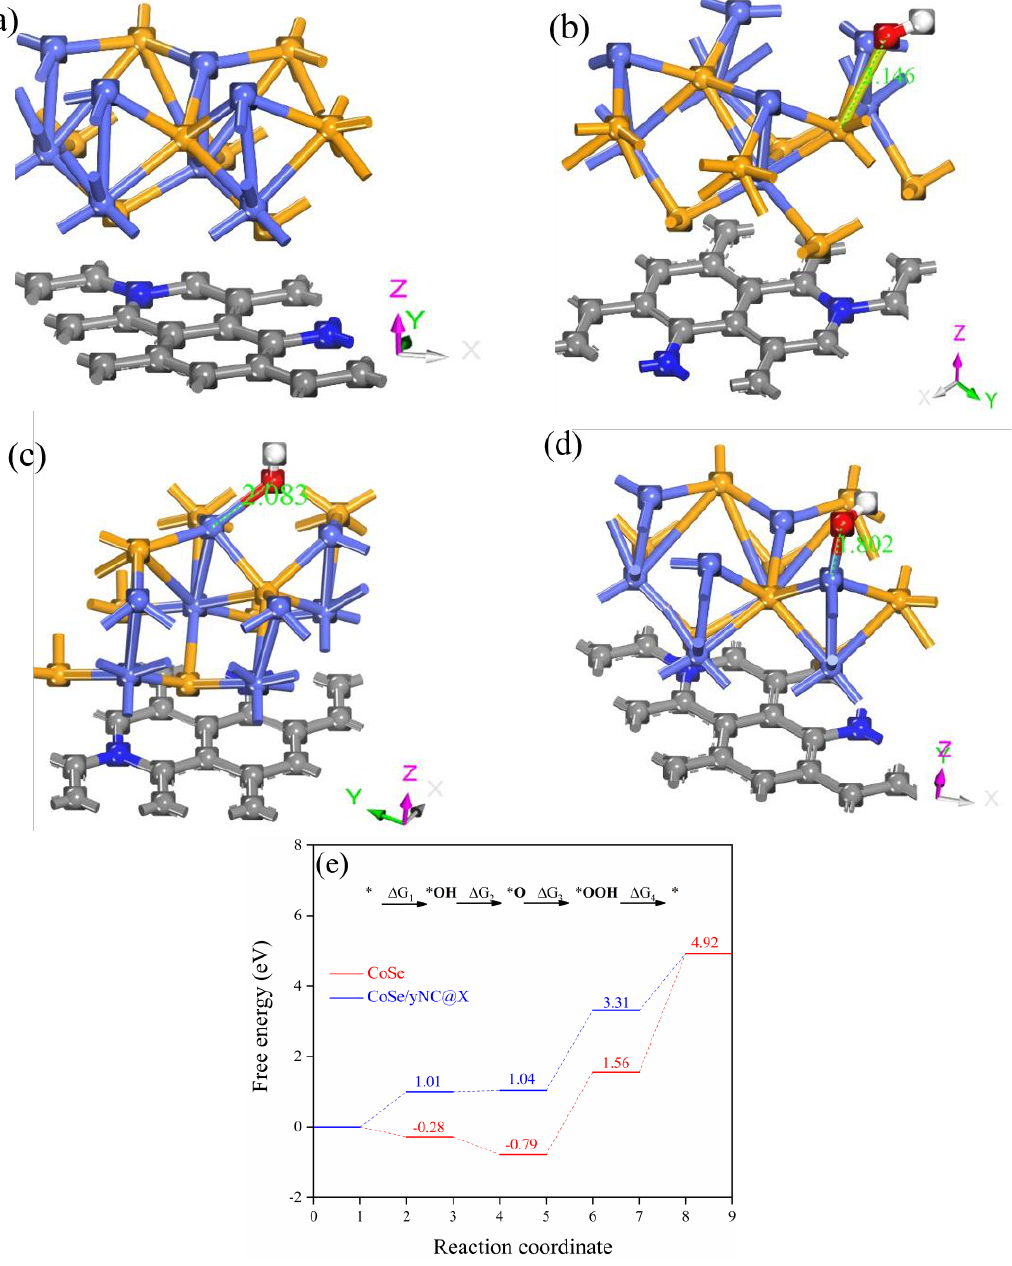
Figure 10. ( a – d ) are four simulated configurations, ( e ) OER process step diagram of CoSe and CoSe/yNC@X.